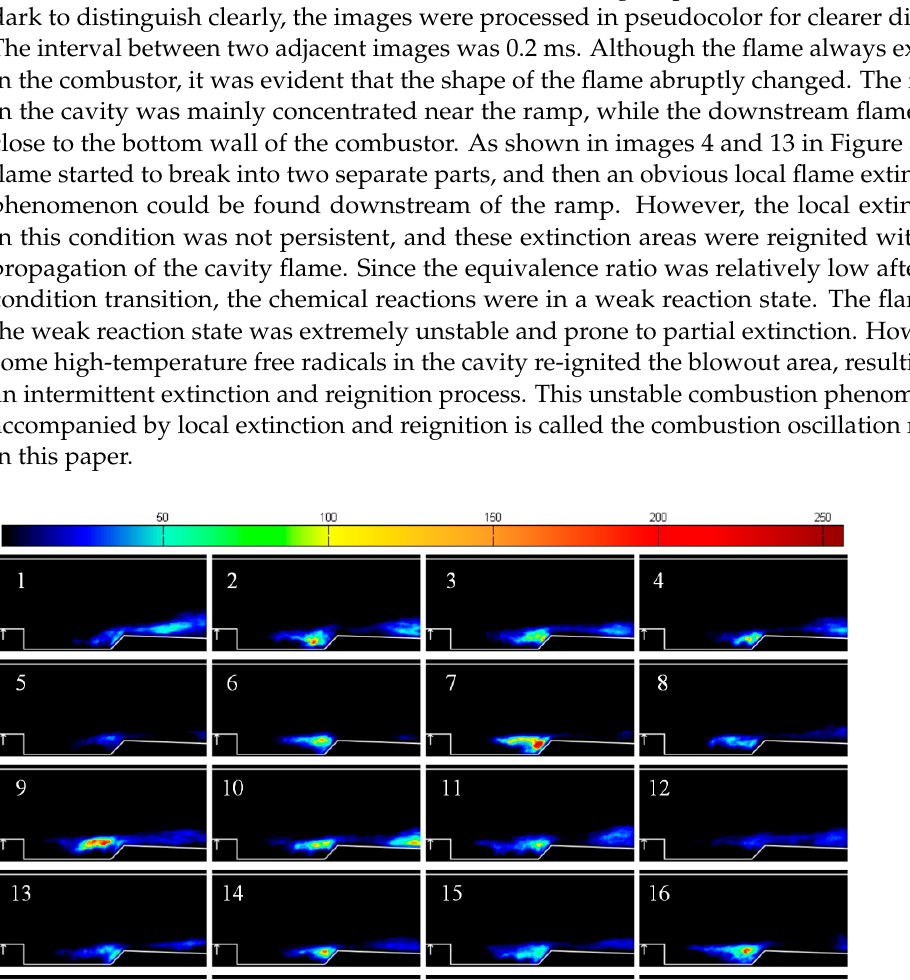
( b ) Figure 7. Normalized light intensity under different injection pressure drops after the condition transition. ( a ) Profiles of the normalized light intensities. ( b ) Probability densities of the normalized light intensities.